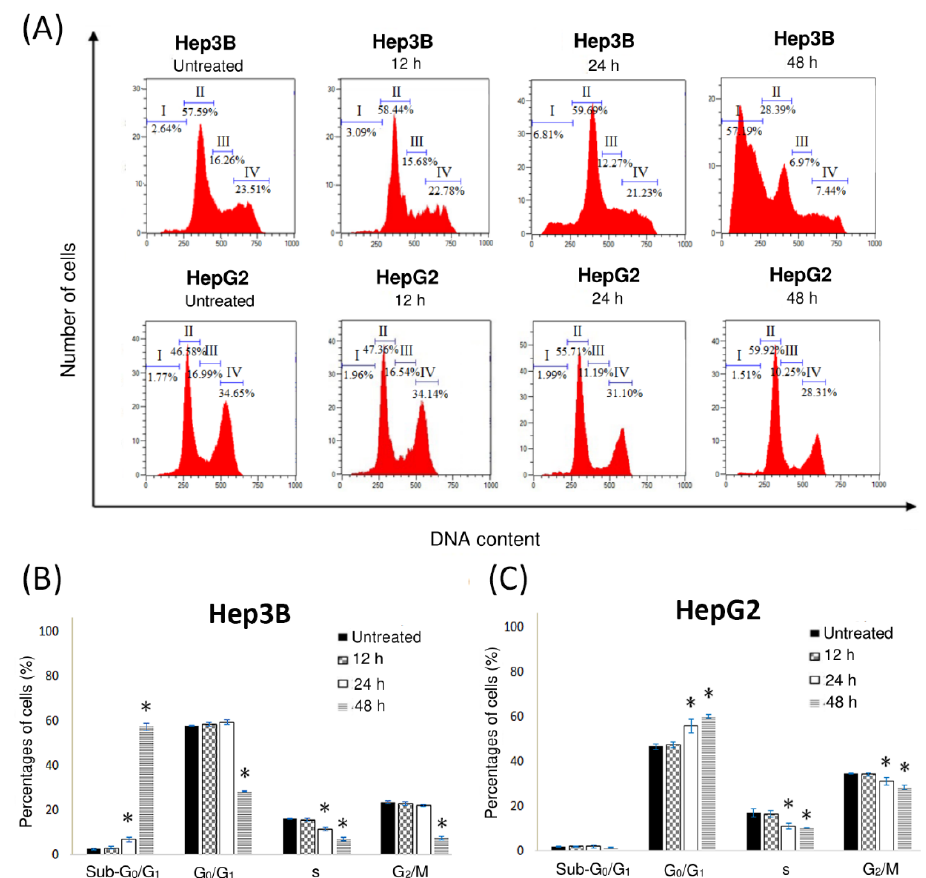
Figure 3. Pinnatane A caused cell cycle arrest in Hep3B and HepG2 cell lines. ( A ) Cell